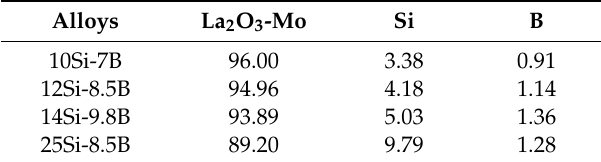
Table 1. Compositions of four series of alloys with di ff erent Si and B contents (wt %).